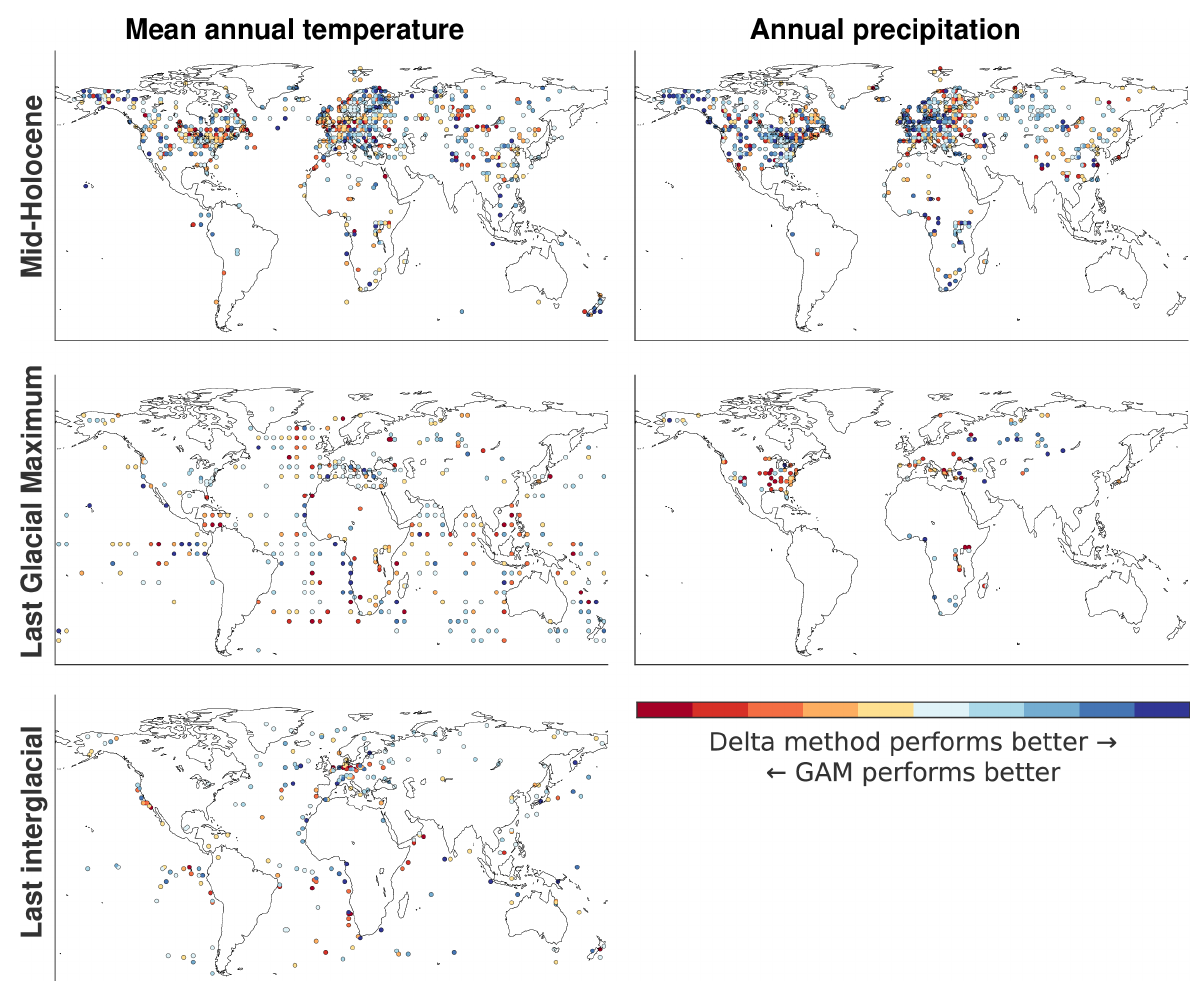
Figure 4. Relative performances of the delta method and the GAM approach in terms of debiasing simulated mean annual temperature (left column) and annual precipitation (right column). The colour spectrum represents the interval [0,1], and marker colours are calculated as the ratio of the absolute value of the local bias (Eq. 6) of the GAM-based approach divided by the sum of the absolute local biases of both